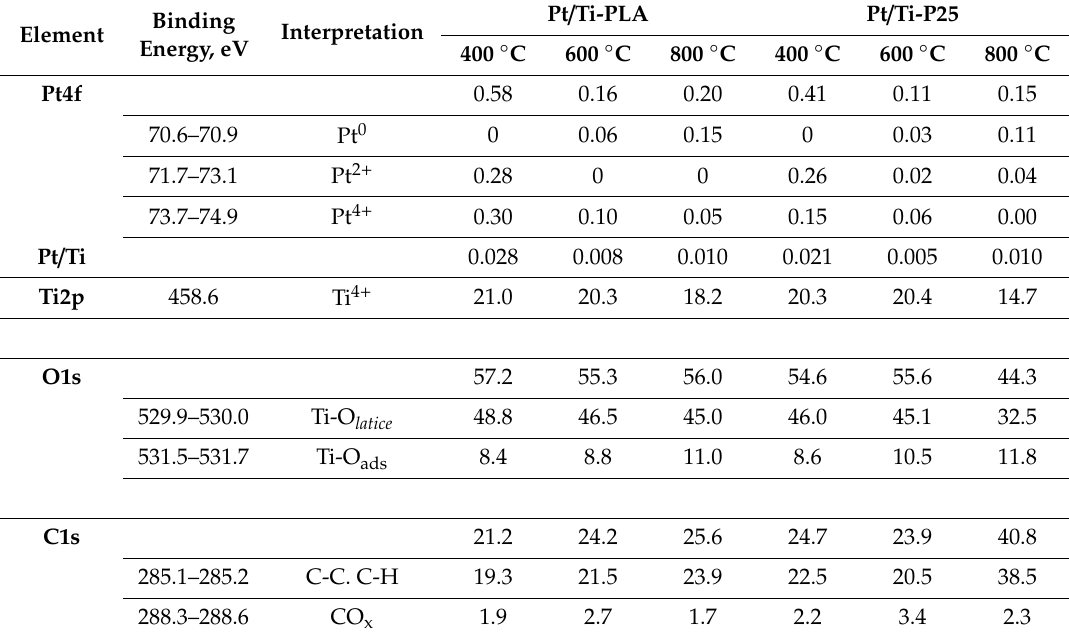
Table 3. Charge states and surface concentrations (atomic %) of the elements by X-ray photoelectron spectroscopy (XPS).